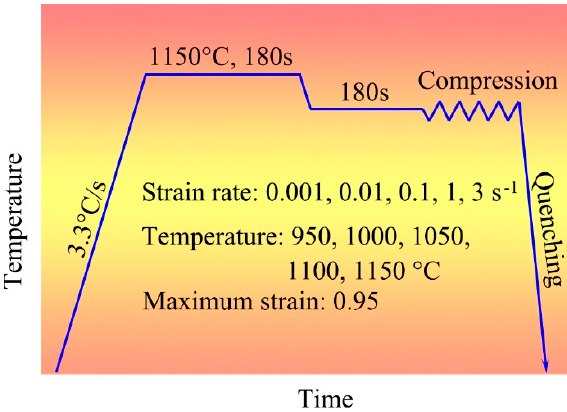
Figure 1. Illustration of the experiment procedure.